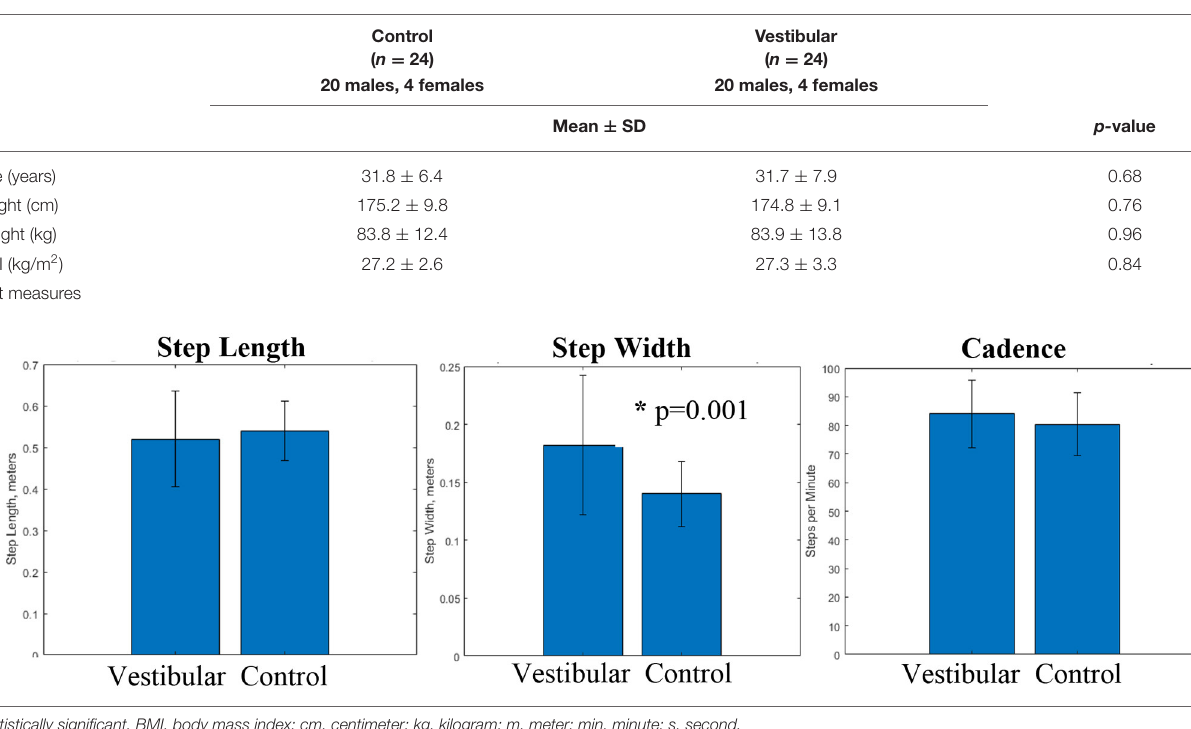
TABLE 1 | Group demographics and spatiotemporal gait